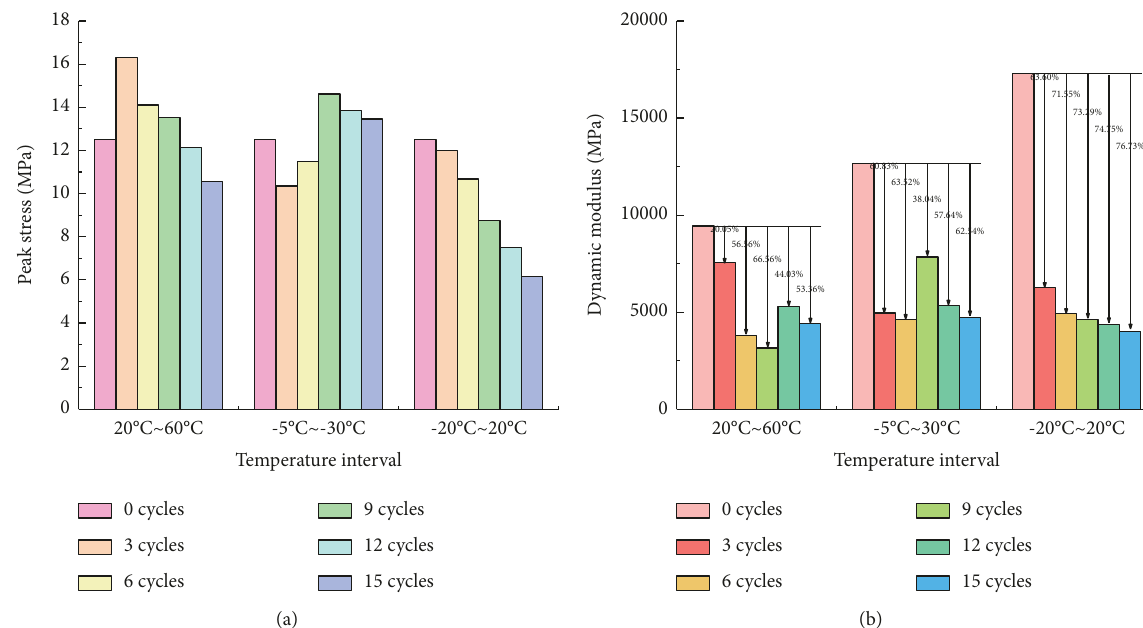
Figure 4: Variation of peak stress and dynamic modulus of semirigid base material with the number of cycles. (a) Variation of peak stress with the number of cycles. (b) Variation of dynamic modulus with the number of